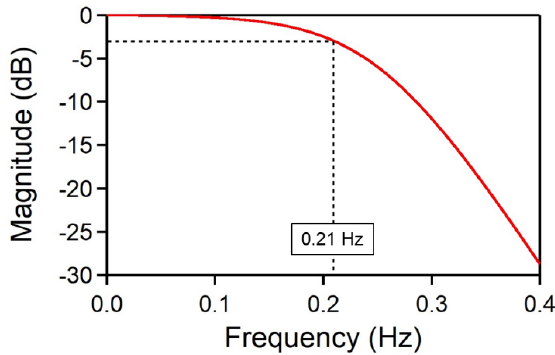
Figure 4. The frequency response of the digital low-pass filter (LPF).